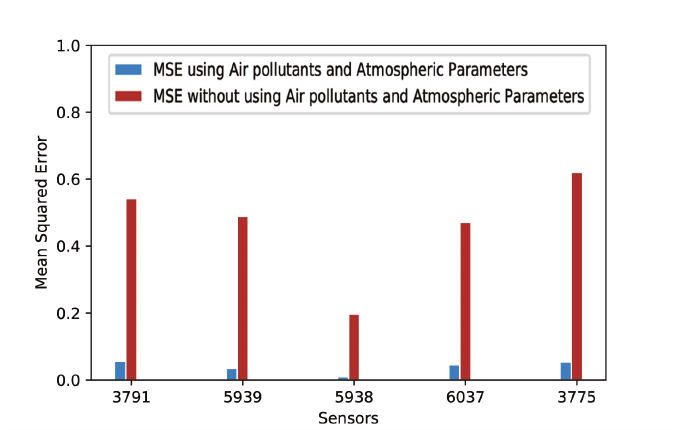
Figure 12. MSE with and without using air pollutants and atmospheric